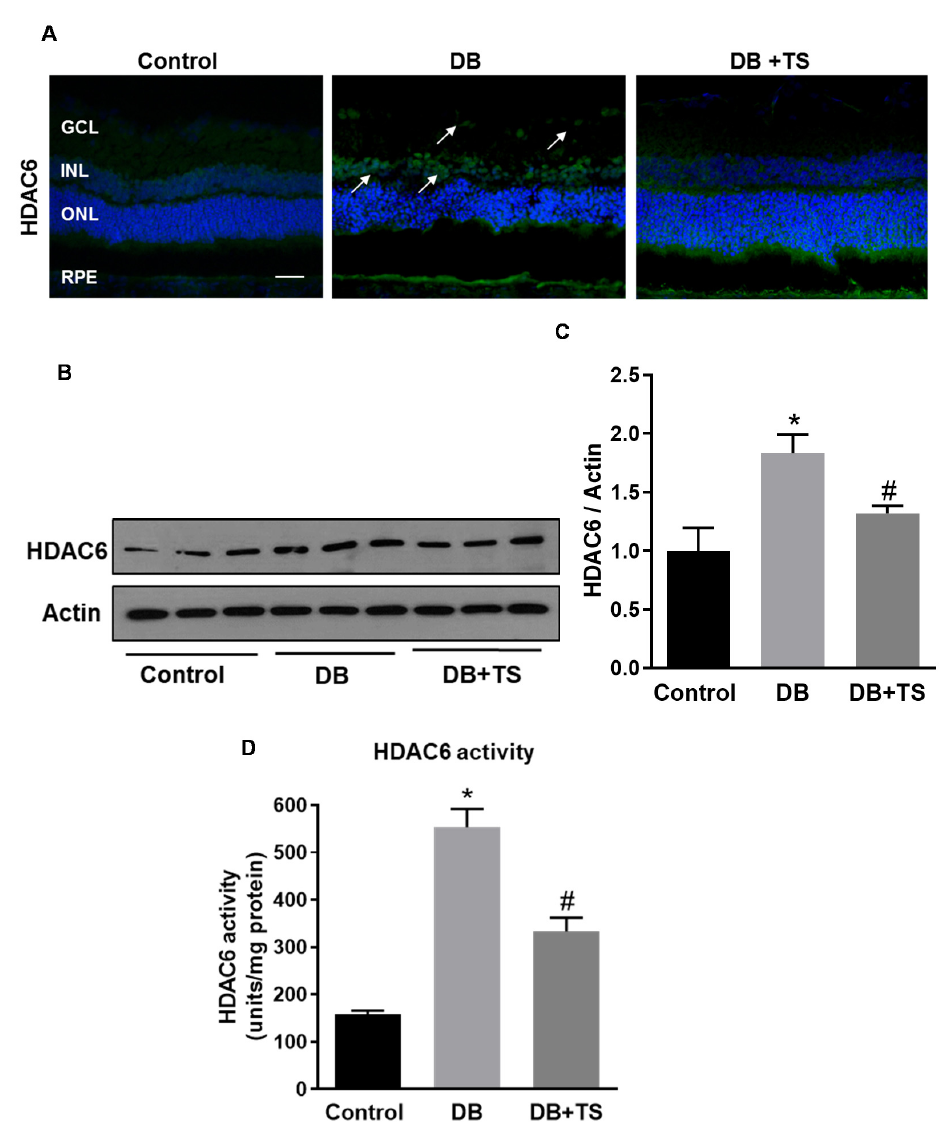
Figure 2. Effects of Tubastatin A on HDAC6 expression and activity. ( A ) Representative images of immunohistochemical analysis of HDAC6 (green) of retinal cryosections of STZ ‐ rats (DB) (8 weeks of hyperglycemia), age ‐ matched normoglycemic control rats, and STZ ‐ rats receiving TS 10 mg/kg (DB + tubastatin A (TS)). Nuclei were stained with DAPI. Scale bar, 50 μ m. ( B ) Western analysis assessing HDAC6 protein levels in STZ ‐ rats after 8 weeks of hyperglycemia (DB), STZ ‐ rats treated with 10 mg/kg TS (DB +TS) and age ‐ matched normoglycemic rats (control). ( C ) Bar histograms representing densitometric values of HDAC6 protein expression measured in the different experimental groups and normalized to actin. ( D ) HDAC6 activity measured, by fluorimetric assay, in the three experimental groups (control, DB and DB + TS). Values are mean ± SEM for n = 6. * p < 0.05 vs. control and # p < 0.05 vs. DB.